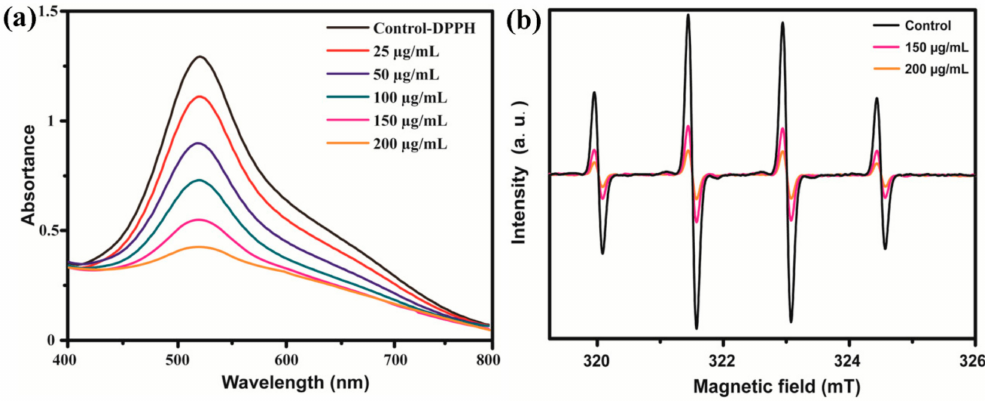
Figure 5. ( a ) DPPH radical scavenging activity of C 60 -PDA-GSH nanoparticles; ( b ) X-band EPR spectra of the DMPO-OH with di ff erent doses of C 60 -PDA-GSH nanoparticles.